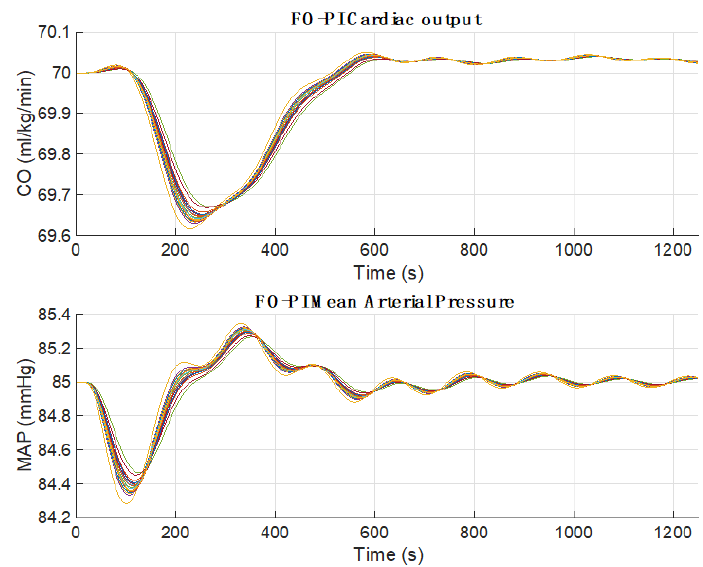
Figure 15. CO and MAP responses of general anesthesia—simulation results with the proposed fractional-order switching function on all 24 patients.